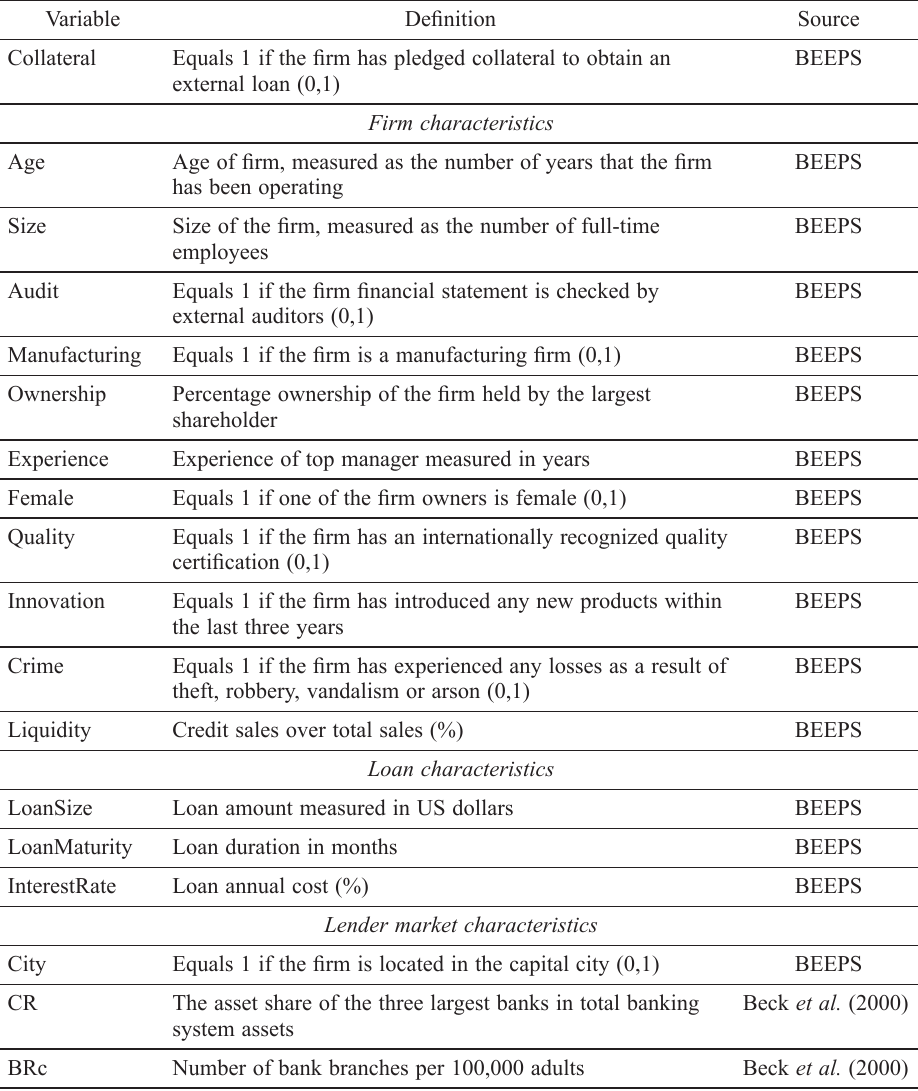
Table 2. Definition and sources of